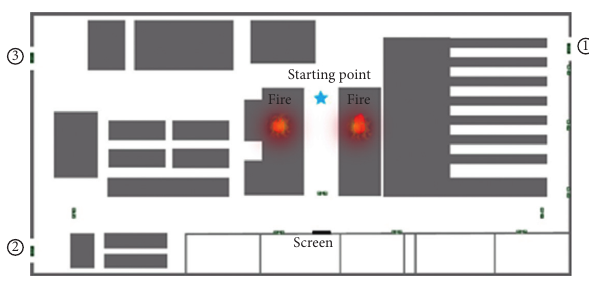
Figure 4: Floor plan of the test